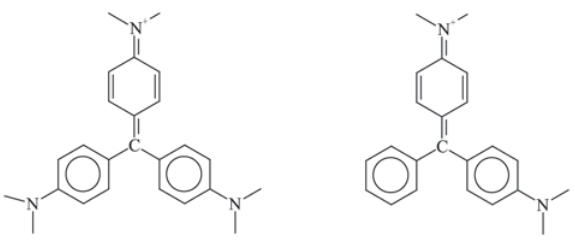
Figure 1. (a) Crystal violet (CV); (b) malachite green (MG) chemi- cal